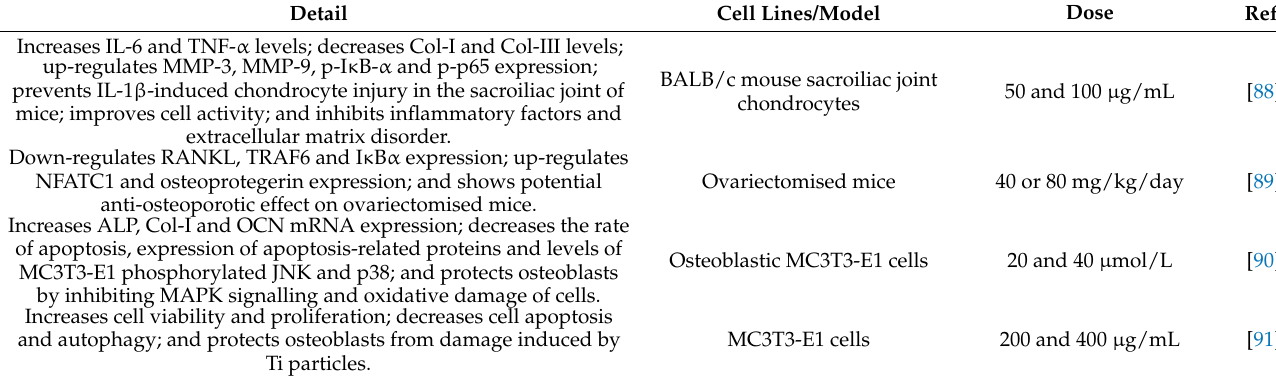
Table 9. Bone-Protective Activity of Hyperoside.